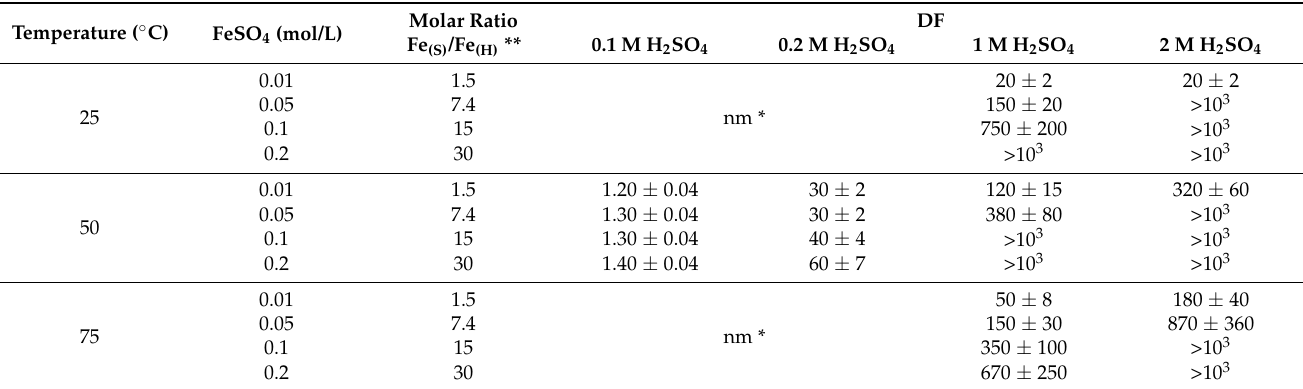
Table 2. Effects of H 2 SO 4 and FeSO 4 concentrations and temperature on the efficacy of decontamina- tion of the model SIER under static conditions.